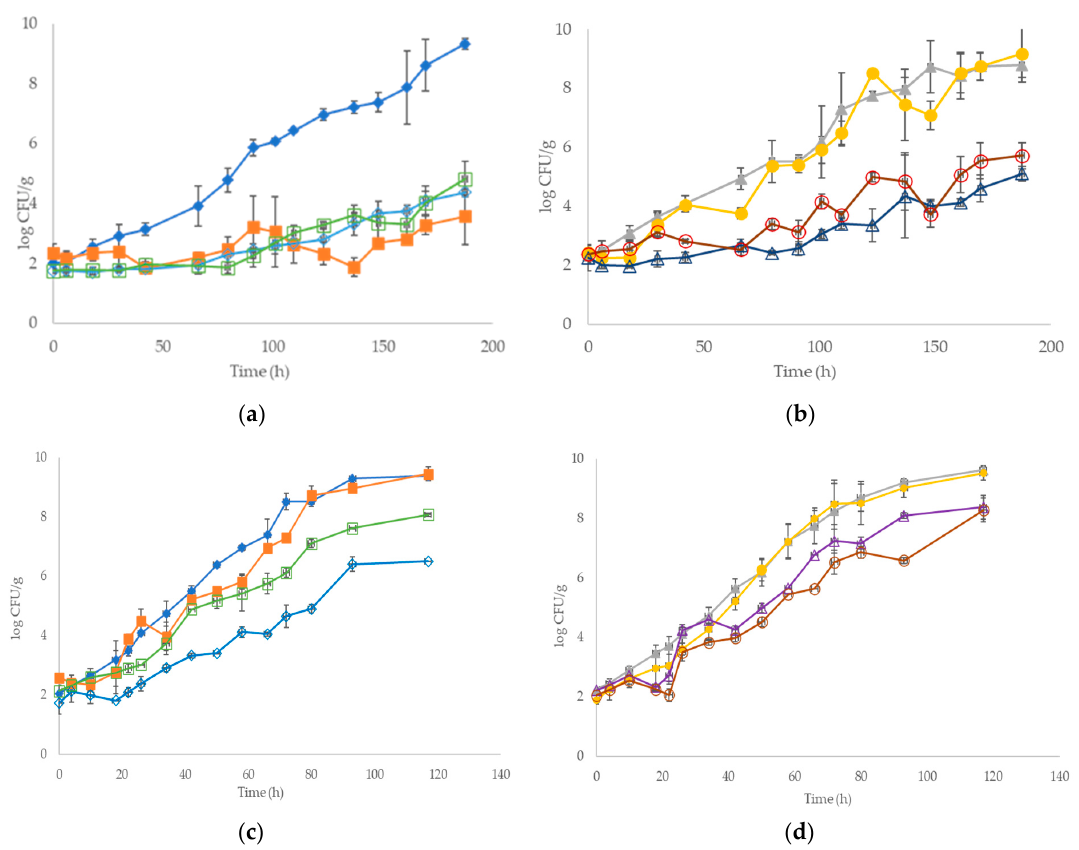
Figure 1 . Population dynamics of the inoculated strains during the storage of pork fillets at 4 °C ( a ) and ( b ) and at 10 °C ( c ) and ( d ). ( ): Pseudomonas fragi , ( ): P. putida , ( ): co-culture of P. fragi and P. putida , ( ● ): population of P. fragi and P. putida in the cocktail culture of the four strains, ( ◊ ): Lactobacillus sakei, ( □ ) Leuconostoc mesenteroides , ( ∆ ): co-culture of Lb. sakei and Ln. mesenteroides and ( ): population of Lb. sakei and Ln. mesenteroides in the cocktail culture of the 4 strains. Datapoints represent mean values ± standard deviation of two replicated samples. Table 1. Estimated kinetic parameters of di ff erent microbial groups in sterile pork meat stored at 4 ◦ C. Inoculation